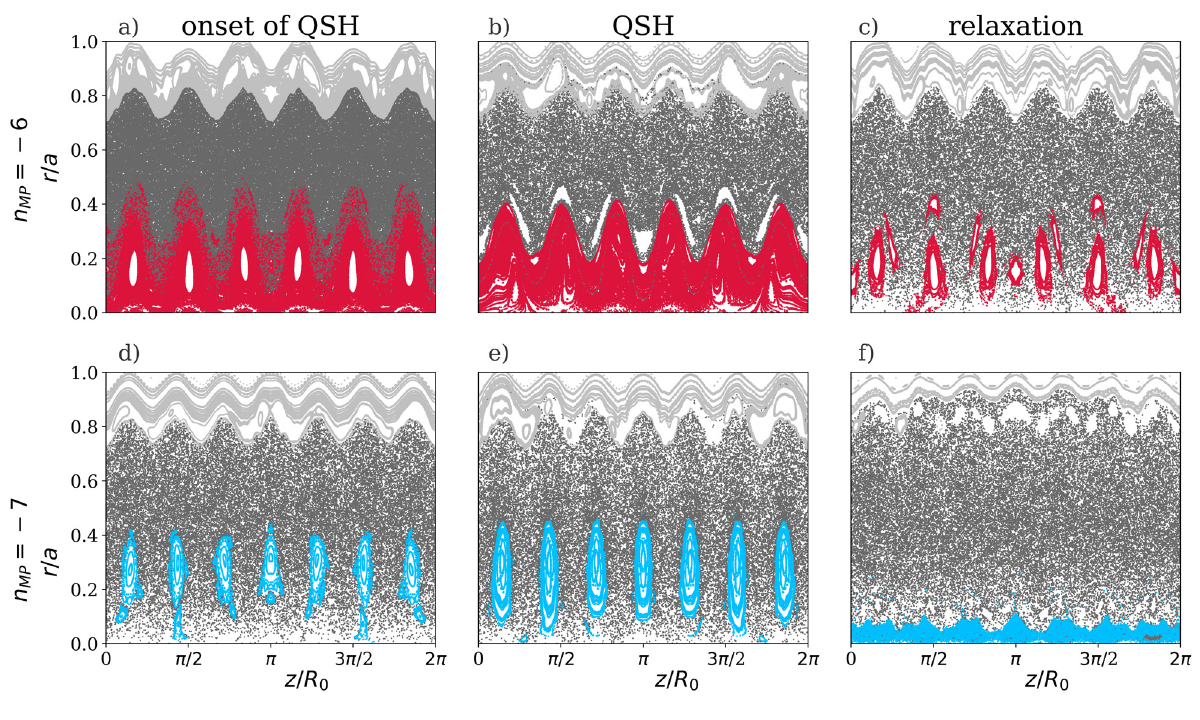
Figure 5. Magnetic topology in terms of Poincaré plots on a toroidal surface of section during the formation of a helical state, and its relation with the helical safety-factor. In the first line the evolution of magnetic field topology during a cycle of formation / breakdown of a non-resonant QSH state with n MP = 6 is shown, while the second line shows a resonant QSH state with n MP = −